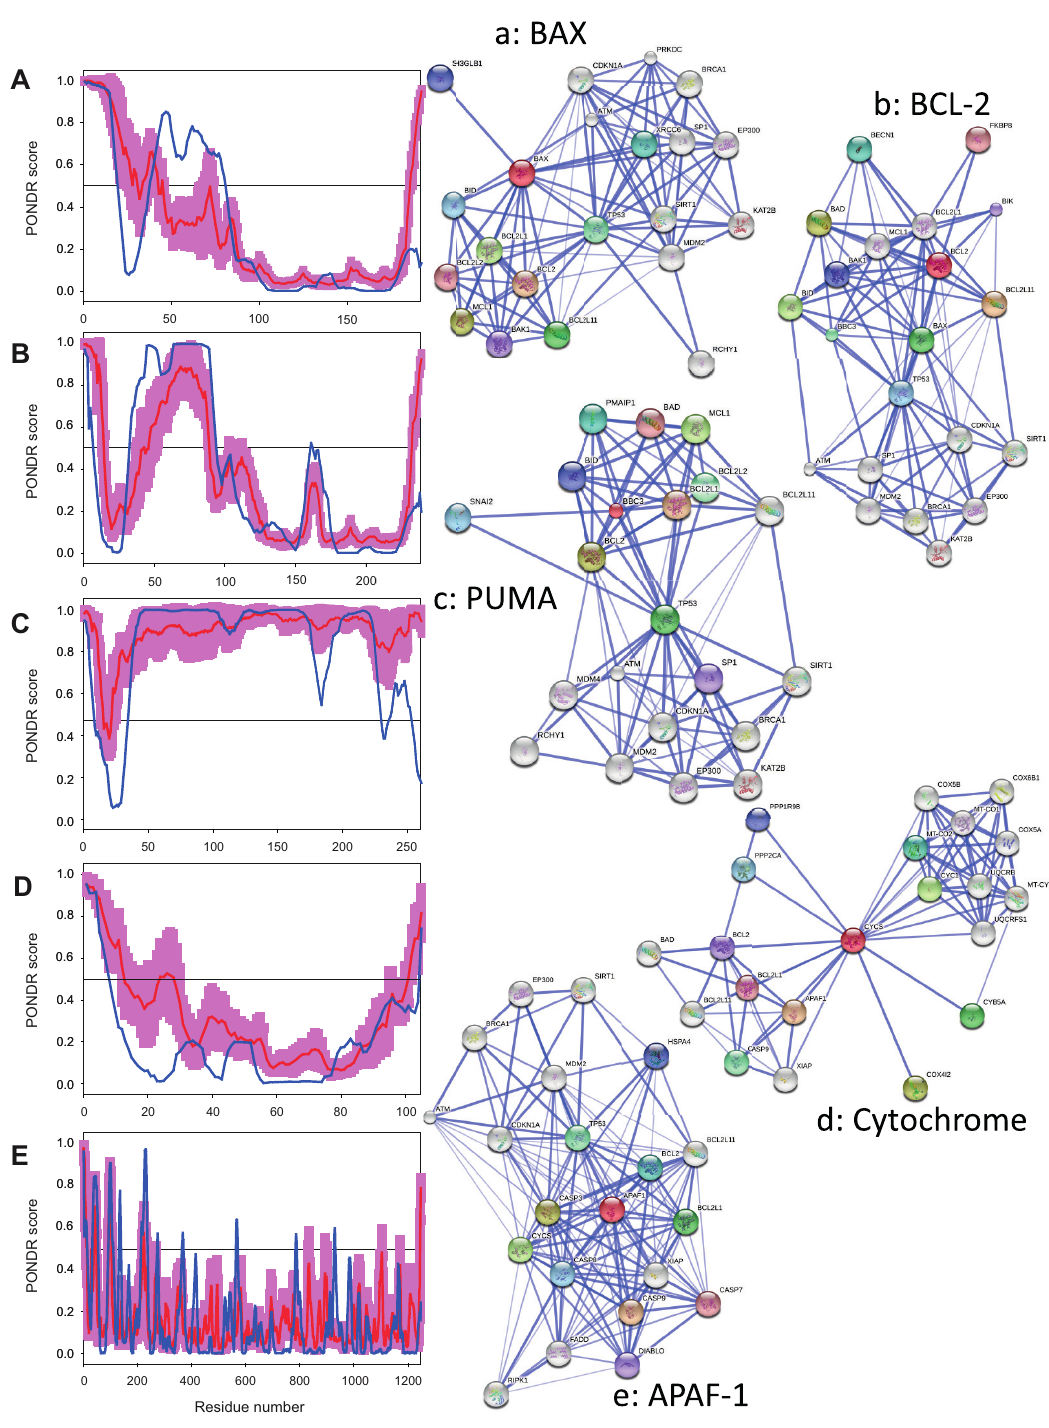
Figure 8. Intrinsic disorder (upper characters) of some human proteins involved in the p53-mediated apoptotic signaling pathways and STRING analysis (lower characters) of their interactomes: group VI. A . and a . BAX (UniProt ID: Q07812); B . and b . BCL-2 (UniProt ID: P10415); C . and c . PUMA (UniProt ID: Q96PG8); D . and d . Cytochrome c (UniProt ID: P99999); E . and e . APAF-1 (UniProt ID: O14727). Intrinsic disorder propensity was evaluated by PONDR-FIT (red curves and pink shadow) and PONDR ® VLXT (blue curves). The shadow